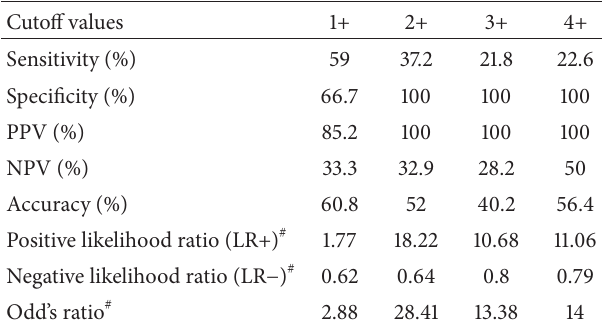
Table 3: Diagnostic test characteristics at different dipstick grades to predict proteinuria of 300 mg/day or more.